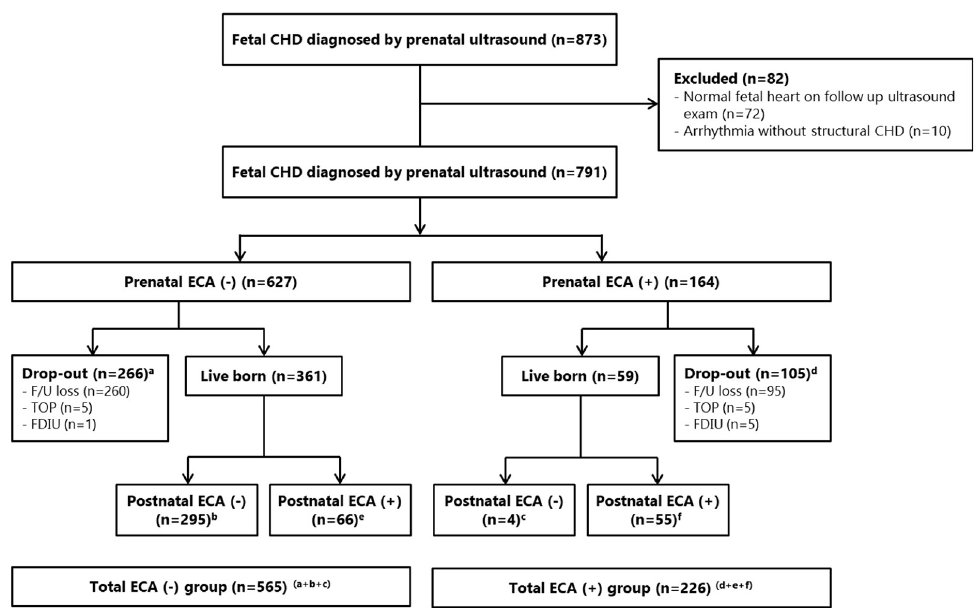
Fig 1. Study population and flowchart. CHD, congenital heart disease; TOP; termination of pregnancy; FDIU, fetal death in utero; ECA, extracardiac anomalies. https://doi.org/10.1371/journal.pone.0248894.g001 microdeletion were found in 6 (7.6%) cases. The rates of chromosomal anomaly and 22q11.2 microdeletion were not significantly different between the prenatal and postnatal tests (chro- mosomal anomaly: 11.5% (prenatal) vs. 11.9% (postnatal), P = 0.922; 22q11.2 microdeletion: 3.5% (prenatal) vs. 7.6% (postnatal), P = 0.213). Among 164 cases who were found to have ECA during the prenatal period, 4 cases were diagnosed as isolated cases by postnatal examina- tions. Among 627 cases of prenatal isolated CHDs, 66 cases were found to have associated ECAs by postnatal examinations (Fig 1). Prevalence of ECA, ECM, chromosomal anomaly and 22q11.2 microdeletion according to